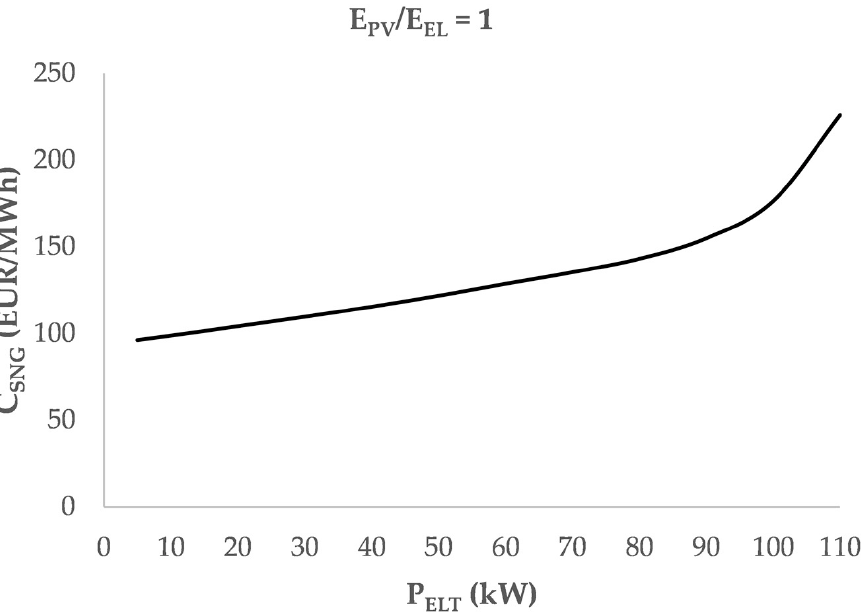
Figure 8. SNG production cost versus the rated power of electrolyser in the scenario E PV /E EL equal to 1.